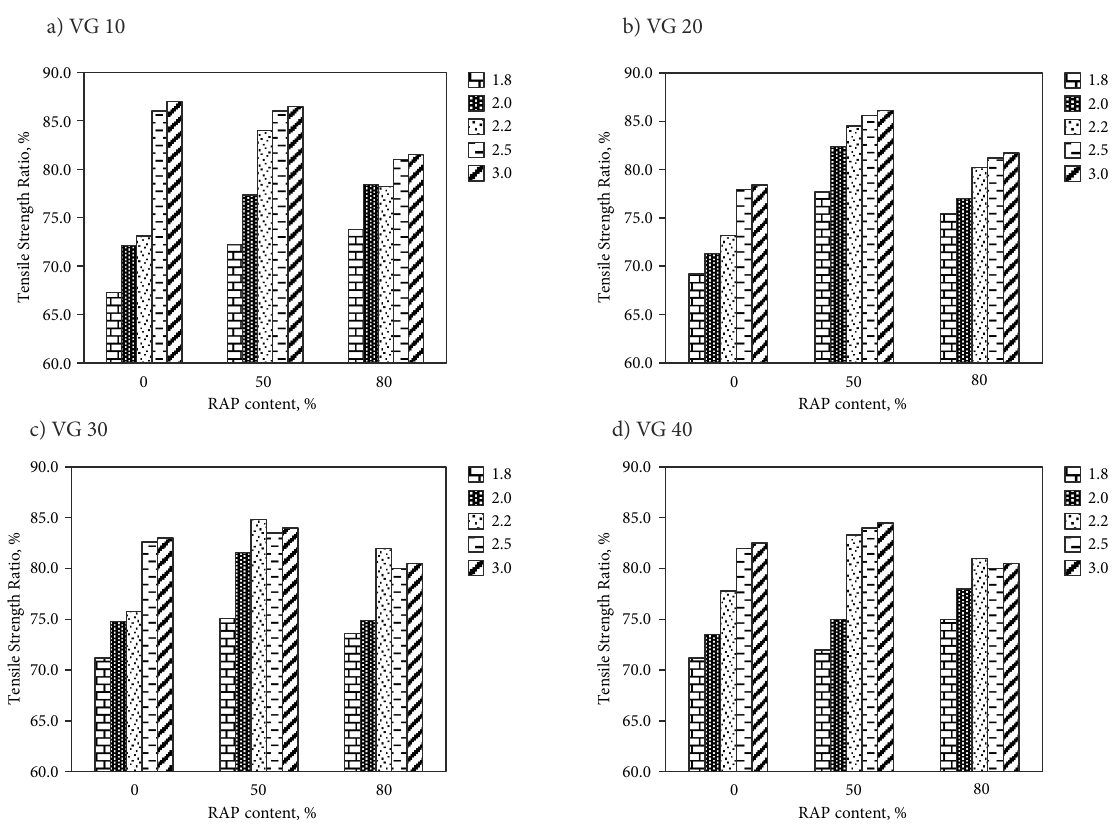
Figure 5. Variation of Tensile Strenght Ratio with Reclaimed Asphalt Pavement percentage and Foamed Bitumen Content